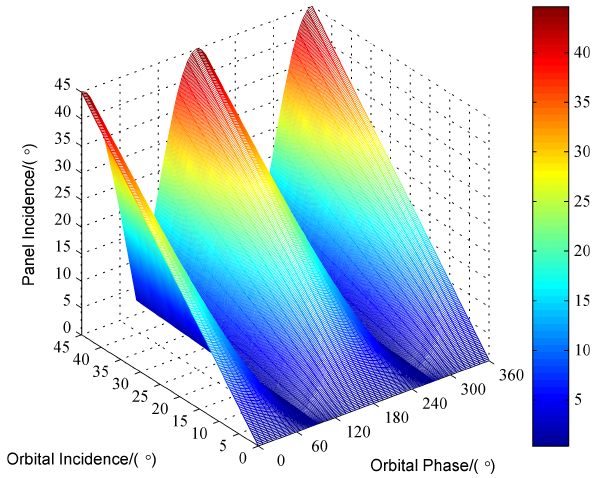
Figure 6. Simulations of the panel incidence incidence simulation is mapped in Figure 6 and the orbital angle is the orbital phase, φ , from Figure 5. The results in Figure 6 show that after the yaw control, the panel incidence is lower than the orbit incidence to on